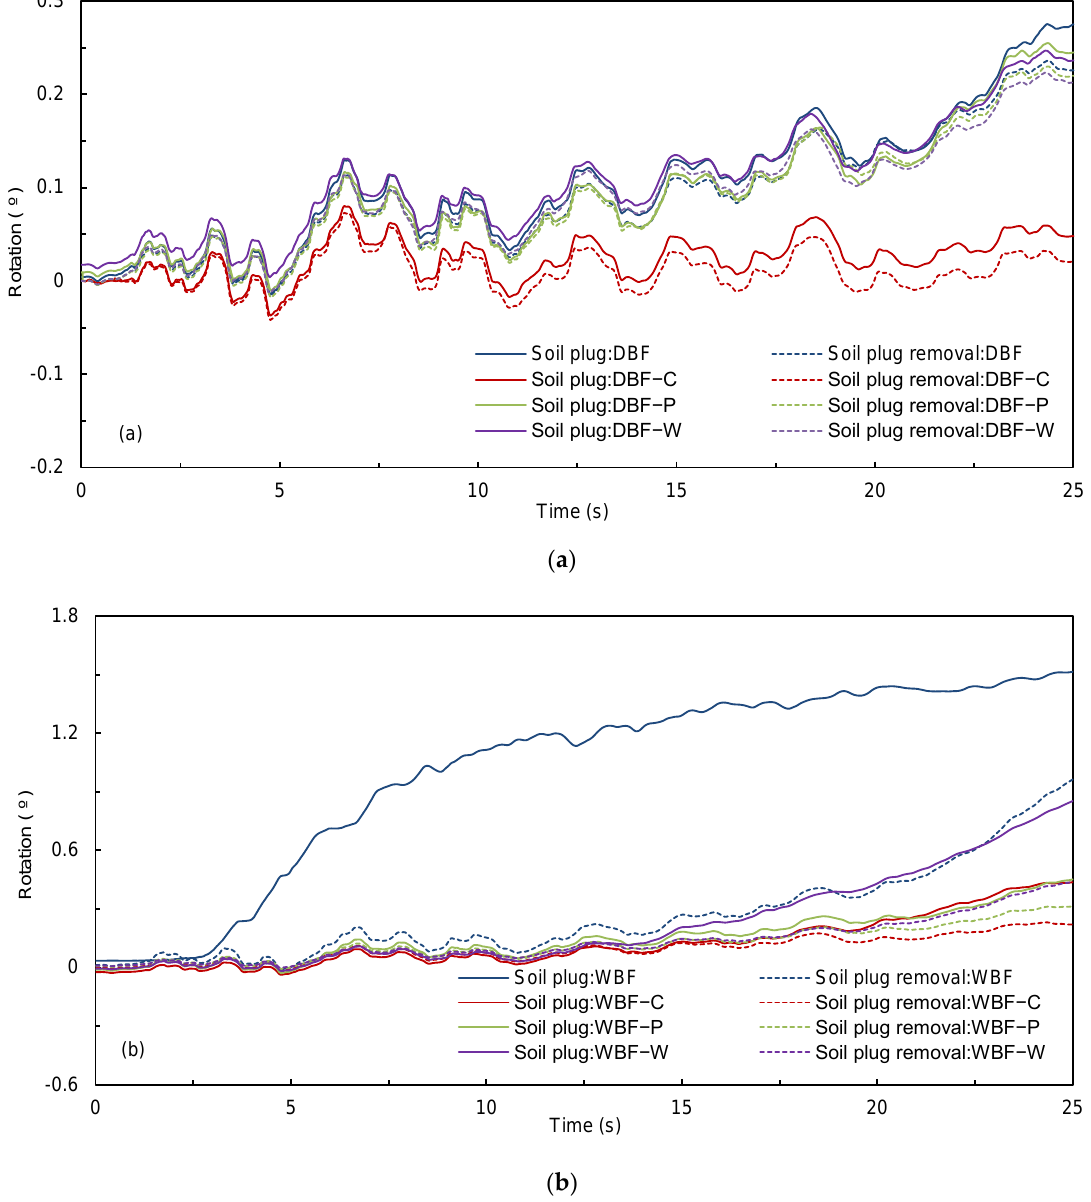
Figure 20. The rotation time histories of unreinforced and reinforced bucket foundations for simu- lations with soil plug and soil plug removal in 50% relative density inclined seabeds: ( a ) deep bucket foundation (DBF); ( b ) wide bucket foundation (WBF). Table 5. Influence of different reinforcement types and soil plug removal on maximum horizontal displacement and maximum rotation response of bucket foundation in 50% relative density inclined liquefiable